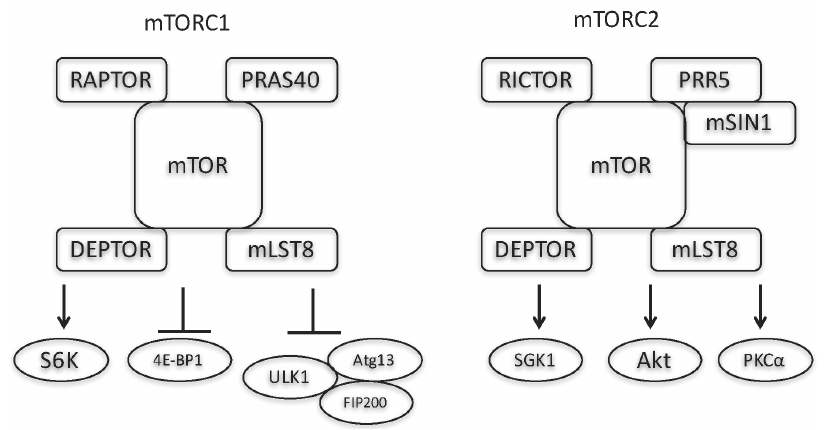
Figure 2. Structures of mTORC1 and mTORC2. mTORC1 phosphorylates substrates including S6K, 4E-BP1, and the unc-51-like kinase 1/mammalian autophagy-related gene 13/focal adhesion kinase family-interacting protein of 200 kDa (ULK1/Atg13/FIP200) complex. mTORC2 phosphorylates substrates including serum/glucocorticoid regulated kinase (SGK) 1, Akt, and protein kinase C- α (PKC α ).